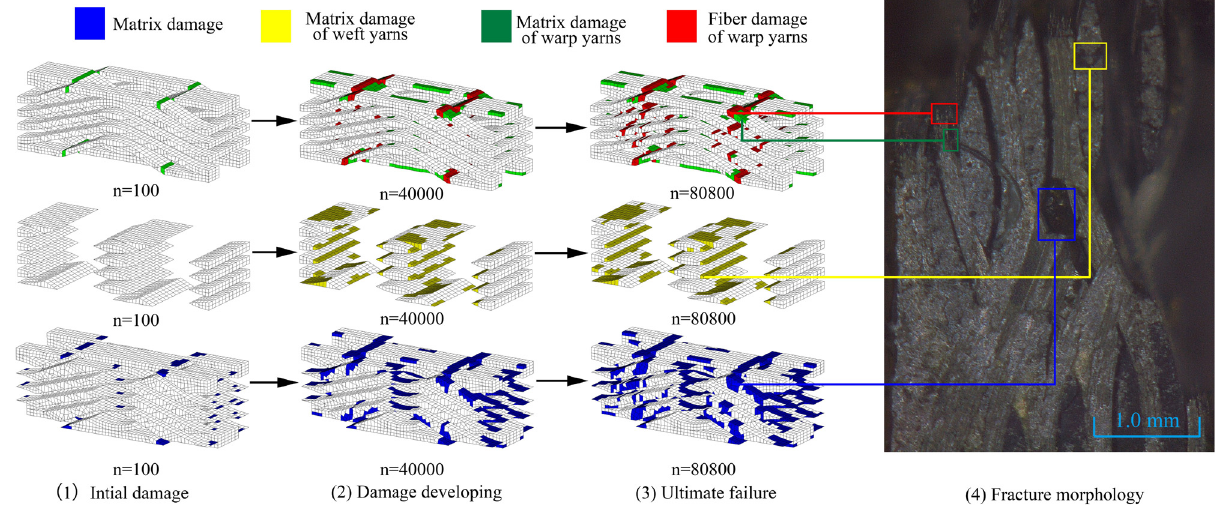
Figure 11: Damage propagation process and experimental fracture morphology of 2.5D woven composites at